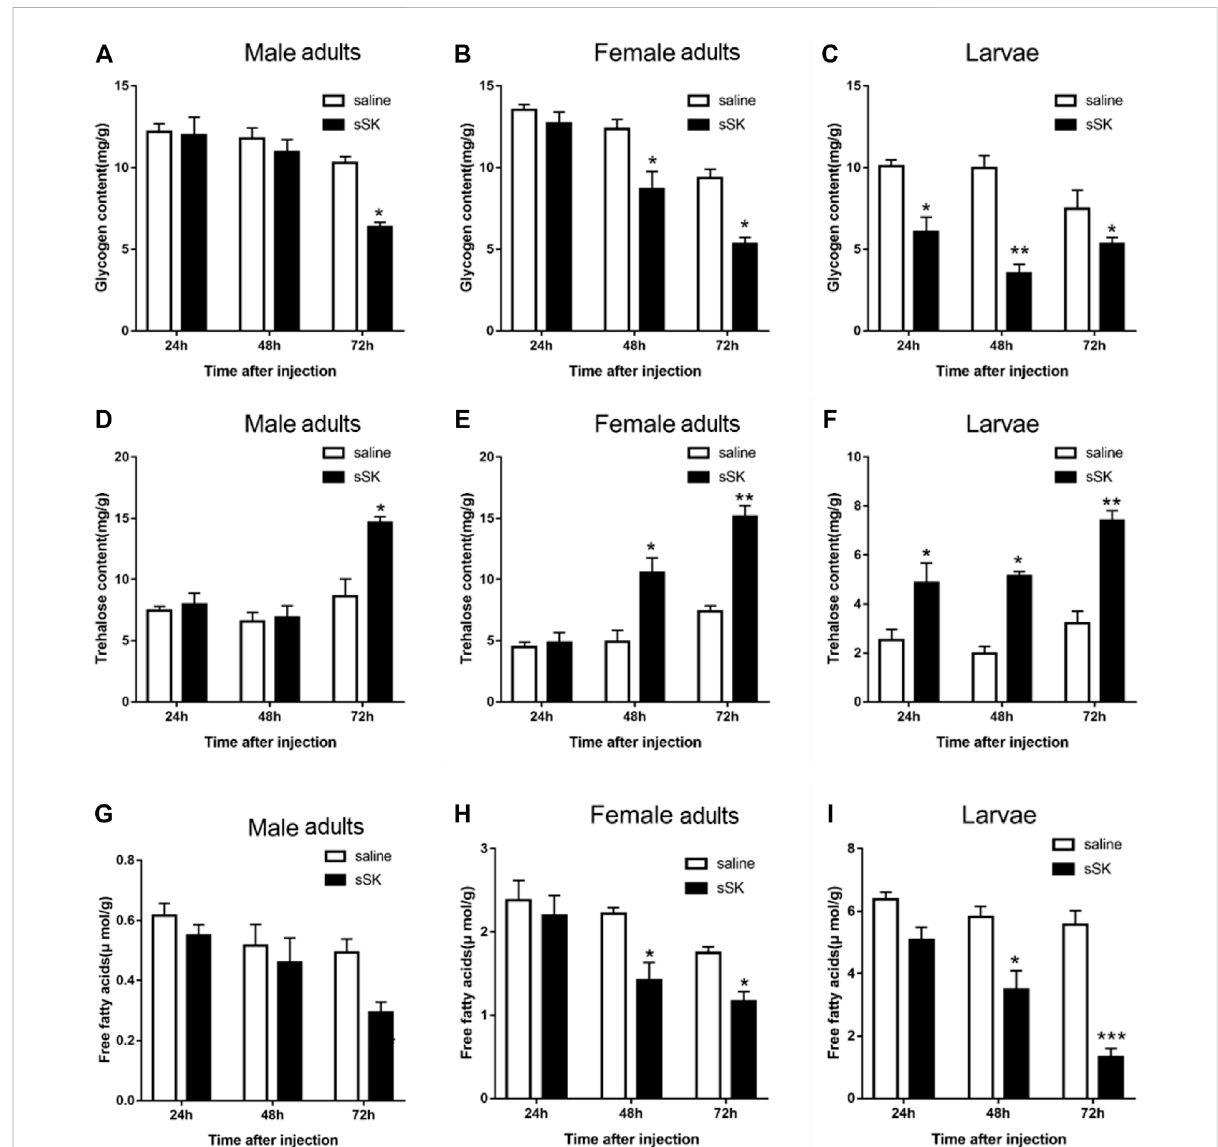
FIGURE 9 EffectofSKonenergymetabolism.Wholebodywasusedtodeterminethecontentsofglycogeninmaleadults (A) ,femaleadults (B), andlarvae (C) ;freefatty acids inmale adults (D) ,femaleadults (E), andlarvae (F); andtrehaloseinmale adults (G) , femaleadults (H), and larvae (I) . Samples were collected at 24, 48, and 72 h after injection. The asterisk indicates a signi fi cant difference between treatments (* p < 0.05 and ** p < 0.01, and *** p < 0.001, one-way ANOVA). All values are mean ± SE , n =